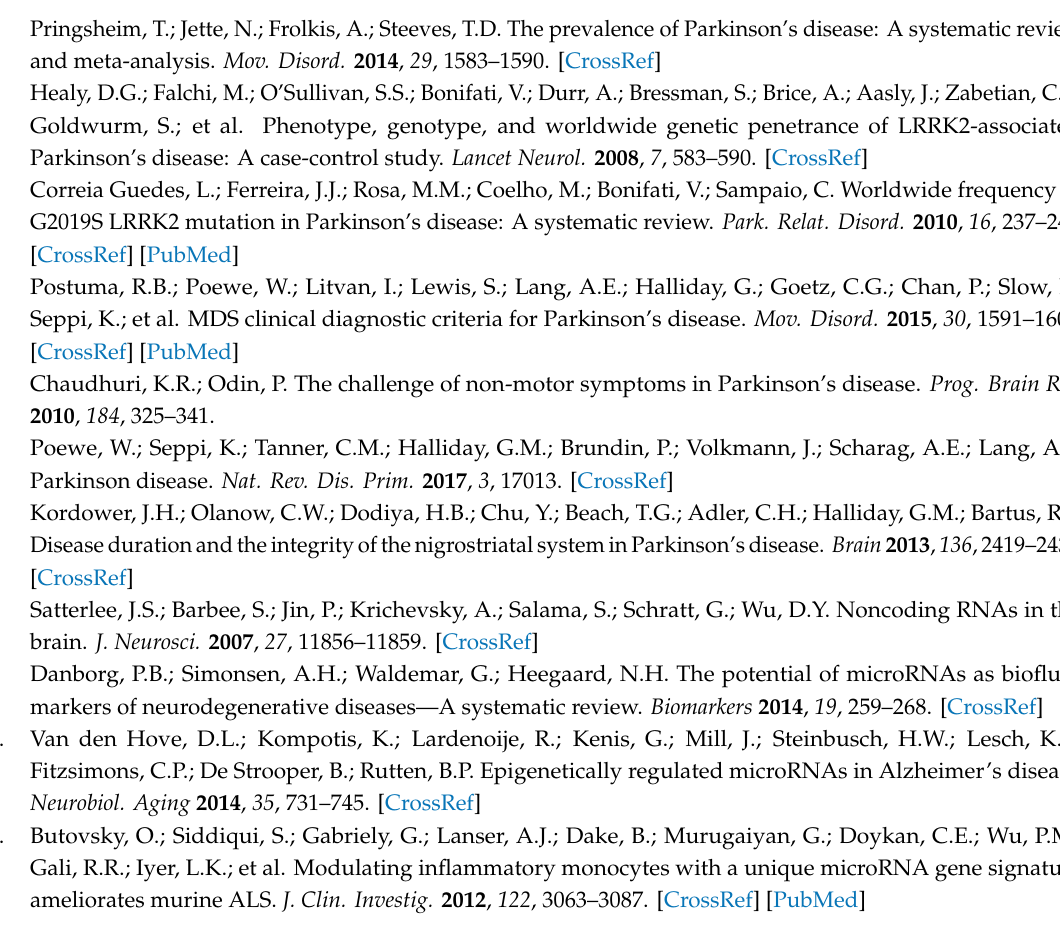
Figure S1: (A) ROC curves of miRNAs in discovery and validation cohorts, discriminating between LRRK2-PD patients and controls. (B) ROC curves of models created from binary logistic regression to improve discrimination between the two groups. AUC values are indicated in each plot, Figure S2: Correlation analysis of all miRNAs among iPD patients and healthy control groups in the validation cohort. Statistically significant correlation ( p < 0.05) and Spearman’s rank correlation coe ffi cient values are indicated in the graphs, Figure S3: Correlation analysis of all miRNAs among iPD patients and healthy control groups in discovery and validation cohorts. Statistically significant correlation ( p < 0.05) and Spearman’s rank correlation coe ffi cient values are indicated in the graphs, Table S1: Correlation analysis between miRNA expression and clinical parameters in discovery and validation cohorts of iPD patients. Correlation coe ffi cient is indicated in the table, Table S2: Correlation analysis between miRNA expression and clinical parameters of iPD and LRRK2-PD patients in discovery and validation cohorts. Correlation coe ffi cient is indicated in the